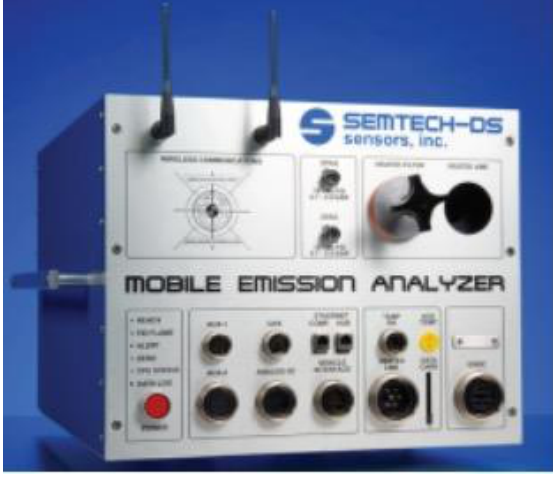
Fig. 3. SEMTECH DS analyzer